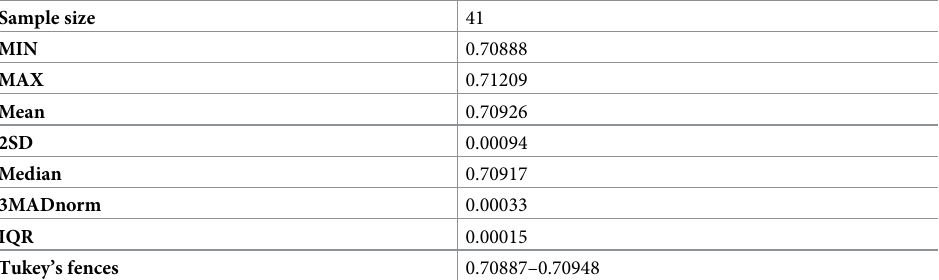
Table 6. Summary statistics for 87Sr/86Sr ratios of bone and tooth specimens.